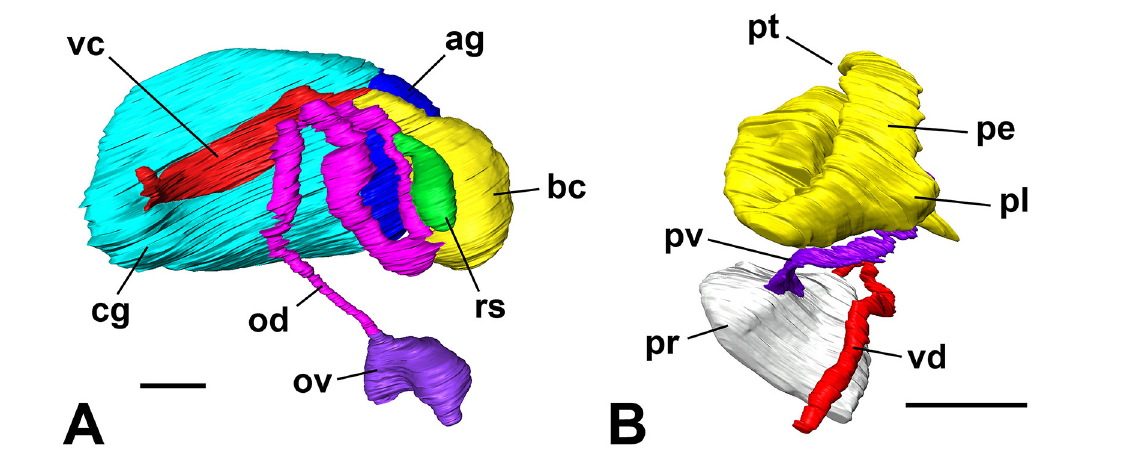
Fig. 10. Genitalia of Opacuincola lisannea sp. nov. µCT scans. A . ♀. B . ♂. Abbreviations: ag = albumen gland; bc = bursa copulatrix; cg = capsule gland; od = oviduct; ov = ovary; pe = penis; pl = penial lobe; pr = prostate; pt = penial tip; pv = pallial vas deferens; rs = receptaculum seminis; vc = ventral channel; vd = vas deferens. Scale bars = 50